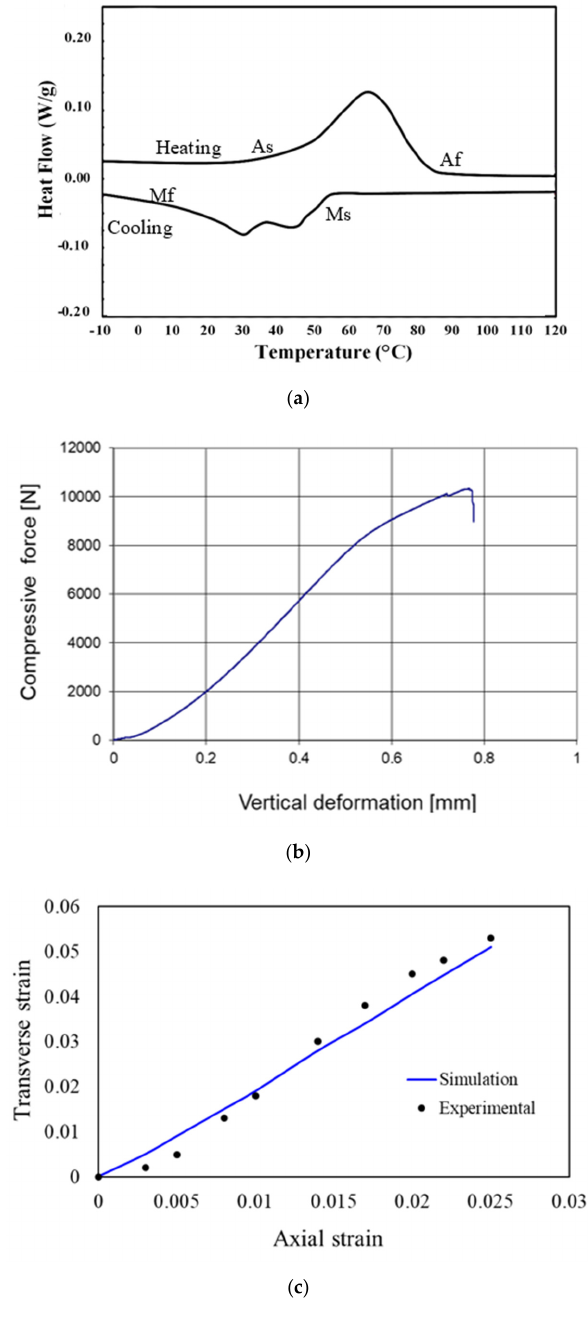
Figure 11. ( a ) DSC curve of the fabricated sample, ( b ) force − displacement curve of one of the fabricated samples using compression testing, and ( c ) experimental and simulated compressive transverse strain versus compressive axial strain for the NiTi auxetic